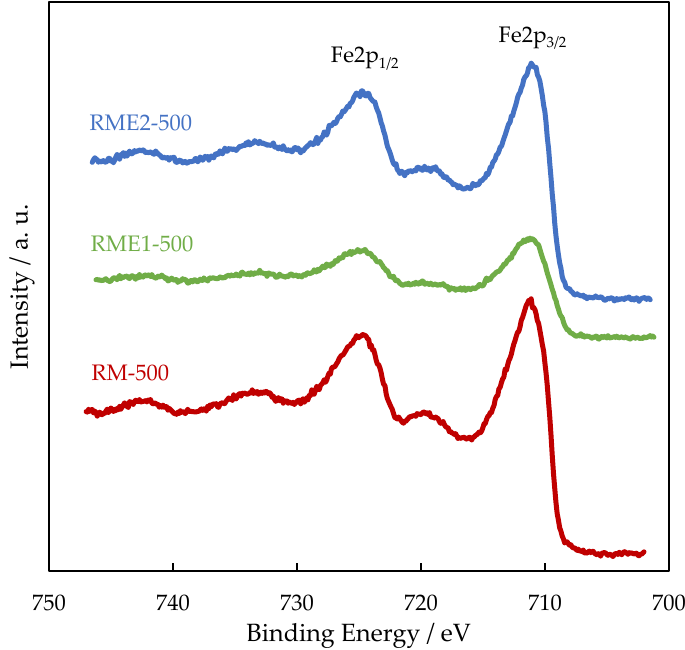
observed at 536.7 eV for RM, RME1, and 536 eV for RM2 is ascribed to the Na KLL Auger Figure 2. X-ray diffraction pattern of ( a ) RM-500 ( b ) RME1-500, and ( c ) RME2-500. shifted for RME2. The values of the binding energies (BE) of the electrons coming from different or- bitals from XPS analysis are shown in Table 3. Table 3. Binding energies of electrons coming from different core levels for the RM and RME samples.